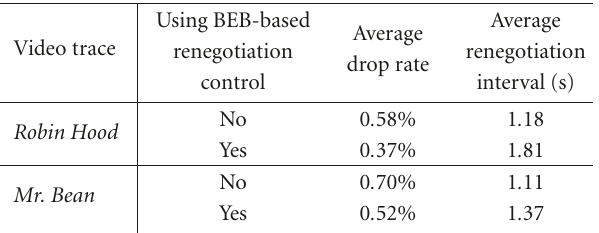
Table 4: E ff ect of BEB-based renegotiation control algorithm on renegotiation interval and bit drop